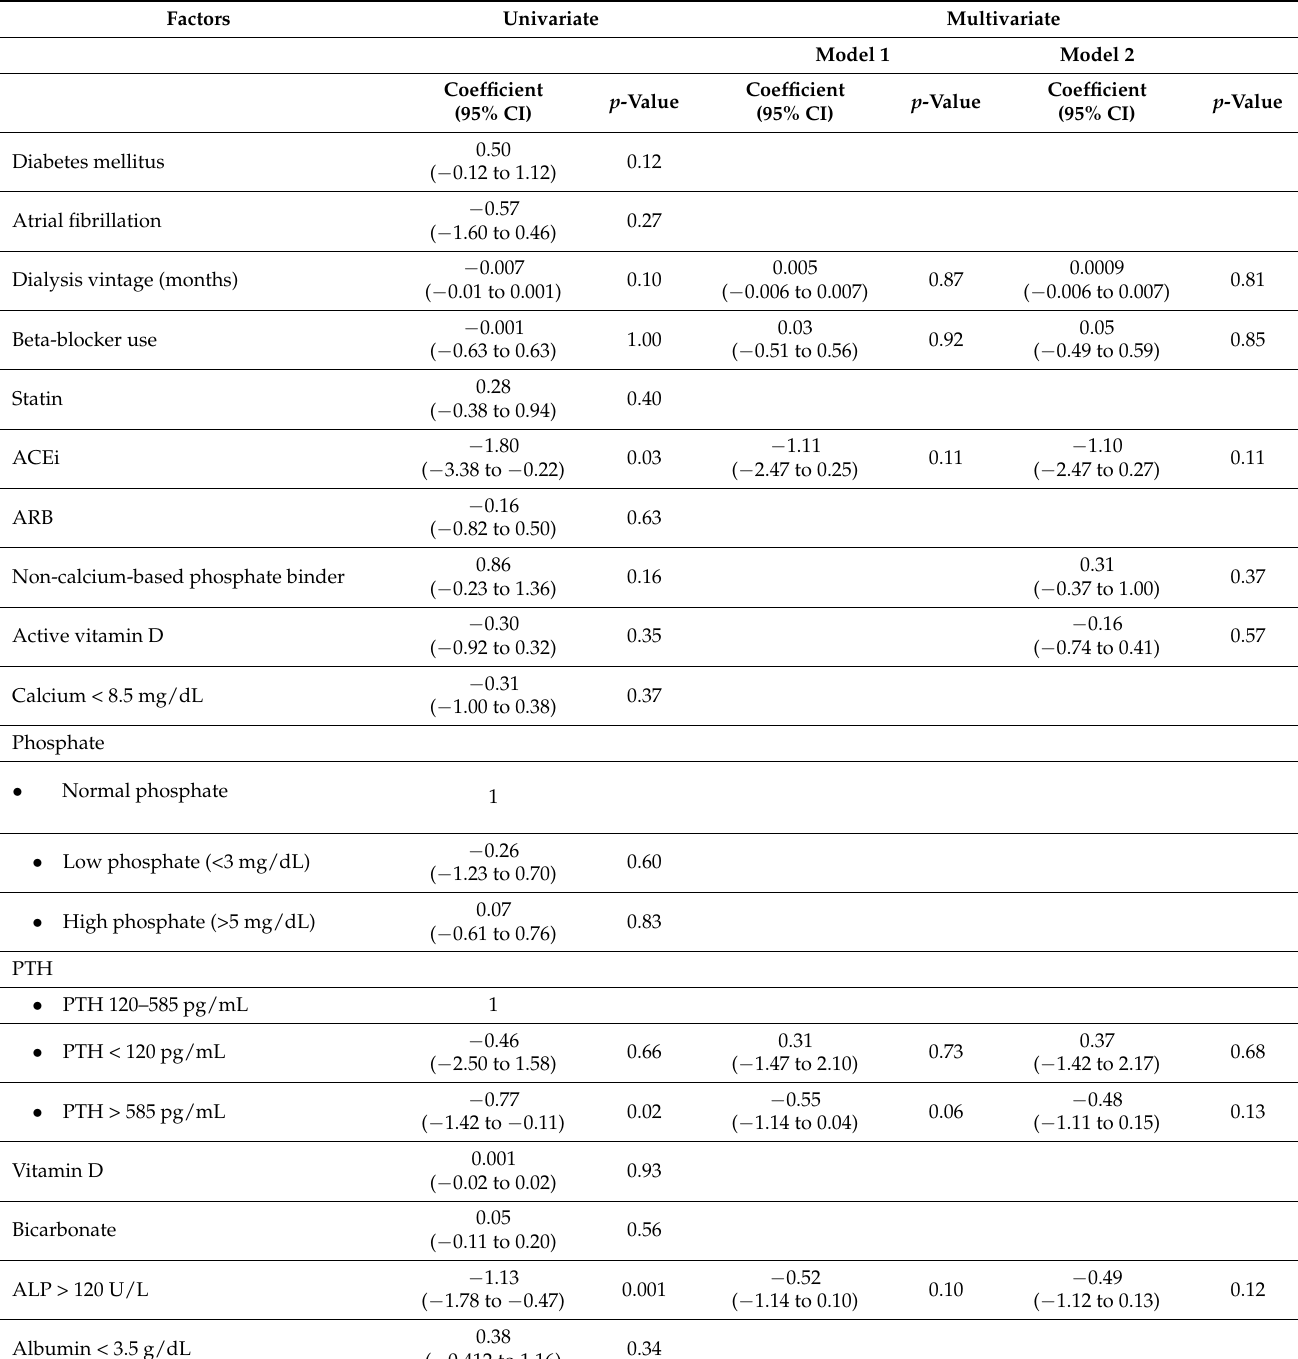
Model 1: Adjusted covariates with p ≤ 0.1 from the univariate model. Model 2: Model 1 + non-calcium- based phosphate binder and active vitamin D supplementation. Abbreviations: ACEi, angiotensin-converting enzyme inhibitor; ALP, alkaline phosphatase; ARB, angiotensin II receptor blocker; BMI, body mass index; PTH, parathyroid